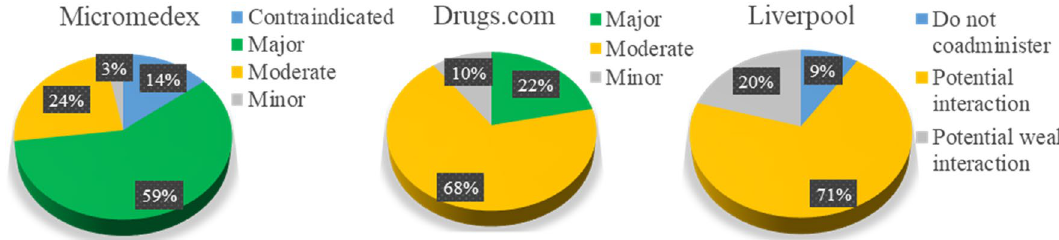
Figure 1. The severity of the potential DDIs characterised by Micromedex, Drugs.com, and